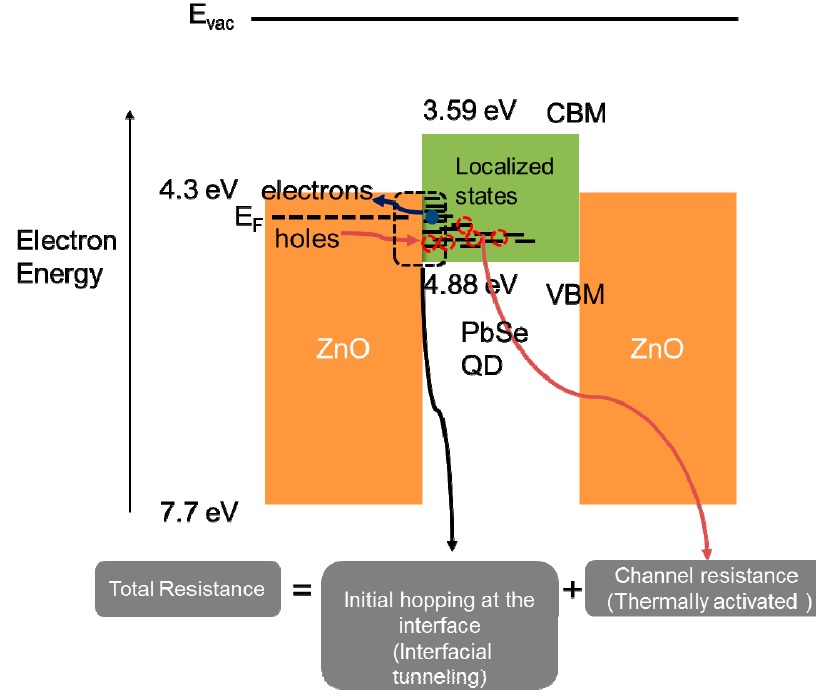
Figure 4. A schematic of ZnO/PbSe (3 nm) charge transfer mechanism in which carrier injection process is dominated by band to band tunneling through localized states in the PbSe QD film.